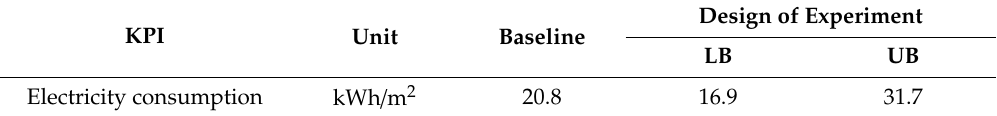
Table 5. Comparison of the baseline and two-level DOE simulation data—lower bound and upper bound of Key Performance Indicator (KPI) yearly values with respect to the baseline.